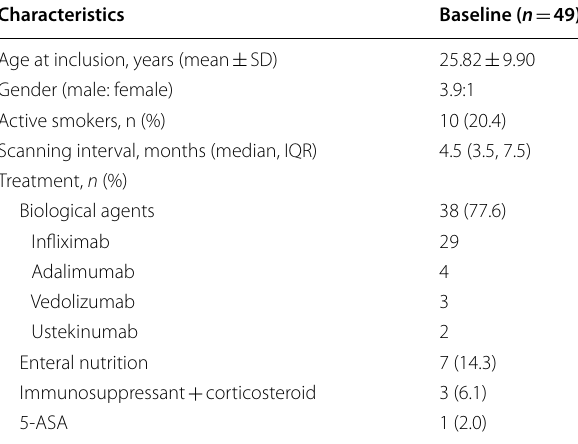
SD Standard deviation, IQR interquartile range, 5-ASA 5-aminosalicylic acid